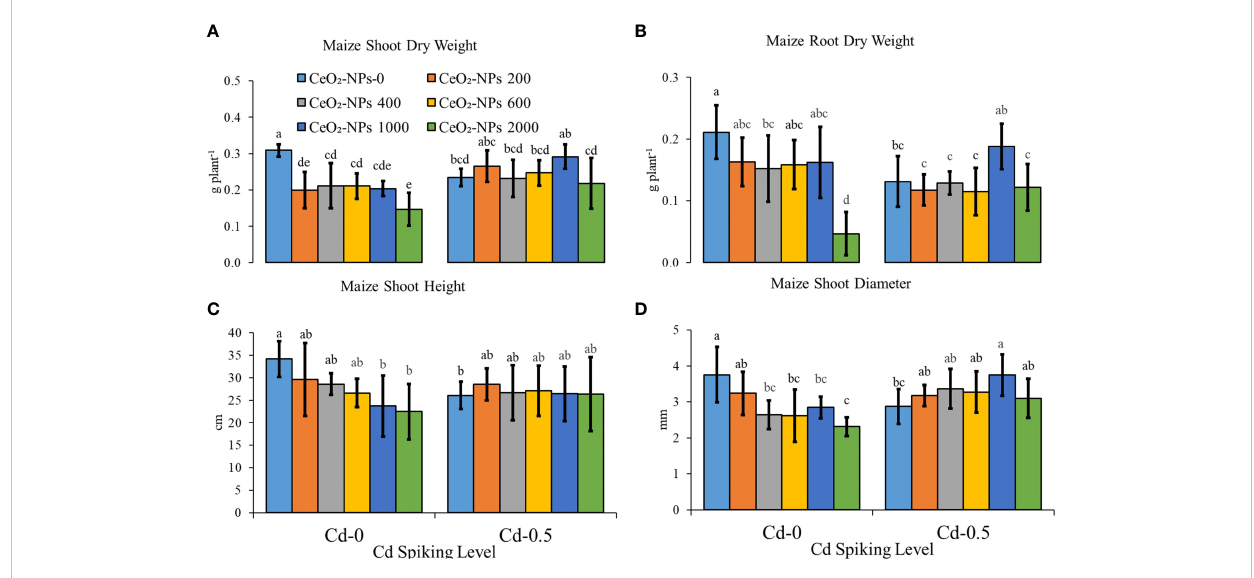
FIGURE 2 Effect of CeO 2 -NPs applied at 200, 400, 600, 1000 and 2000 mg kg -1 dry sand, alone and in combination with 0.5 mg kg -1 Cd on maize growth. (A) shoot dry weight (g), (B) root dry weight (g), (C) plant height (cm), (D) plant diameter (mm). The graphs are of mean ( n = 4) ± standard deviation. Letters shown pair wise comparison via Least Signi fi cant Difference (LSD) at p ≤